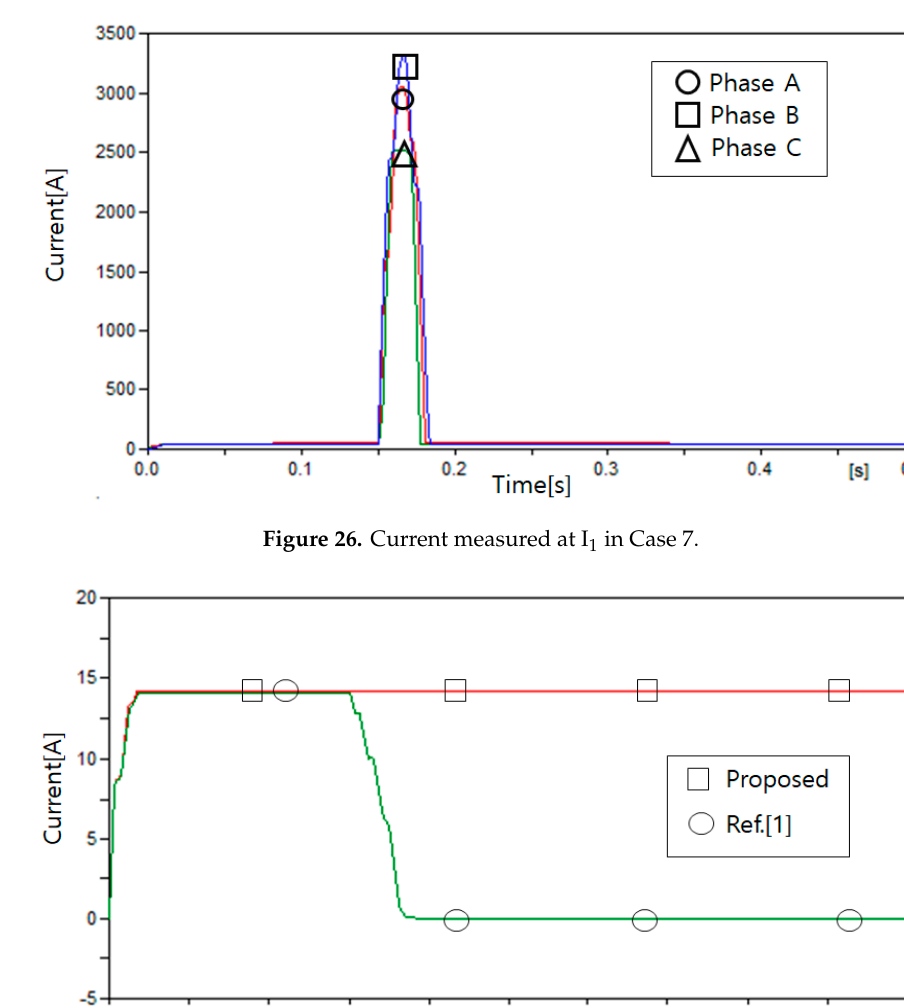
Figure 25. Fault location in Case 7.